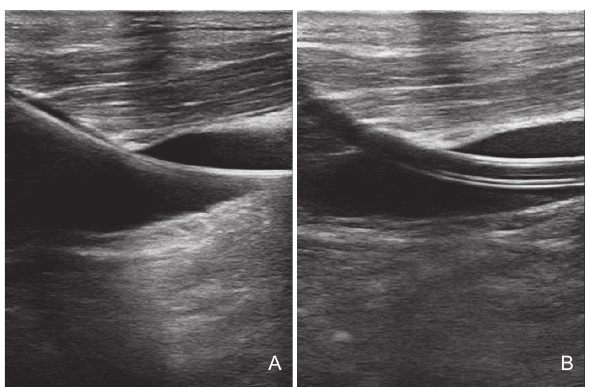
Figure 20 Ultrasound-guided internal jugular vein puncture and placement. (A) Place the guidewire along the puncture needle under ultrasound guidance; (B) Place the catheter along the guidewire under ultrasound